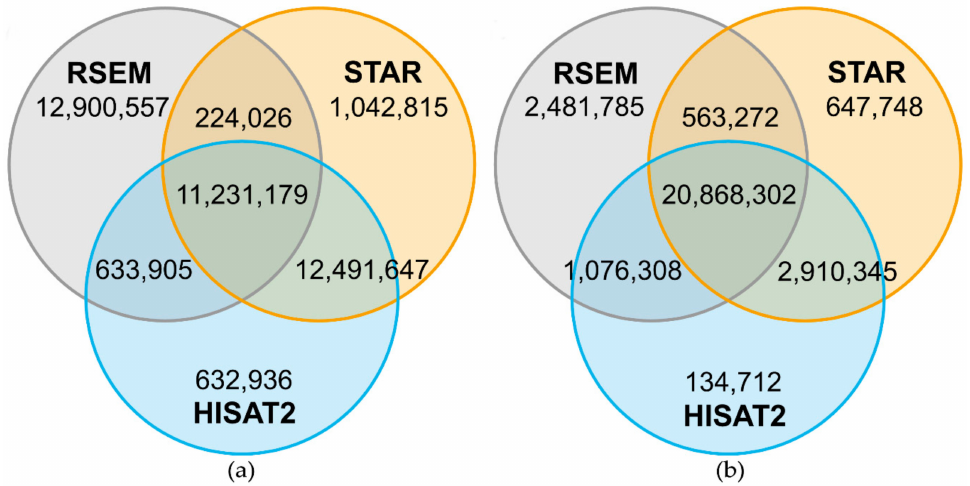
Figure 6. Number of reads mapping on the same genomic position comparing HISAT2, RSEM and STAR for Col-0. Venn diagrams are based on 24,989,667 reads mapped by all three mappers and represent the overlap of mapped reads on the same genomic position for sample A (see Table A3 for sample information). A high number of the uniquely mapped reads in RSEM was based on soft-clipping by one bp performed by HISAT2 and STAR ( a ). The reads in HISAT2 and STAR were corrected by adding the soft-clipped bp back and the overlap with RSEM increased strongly ( b